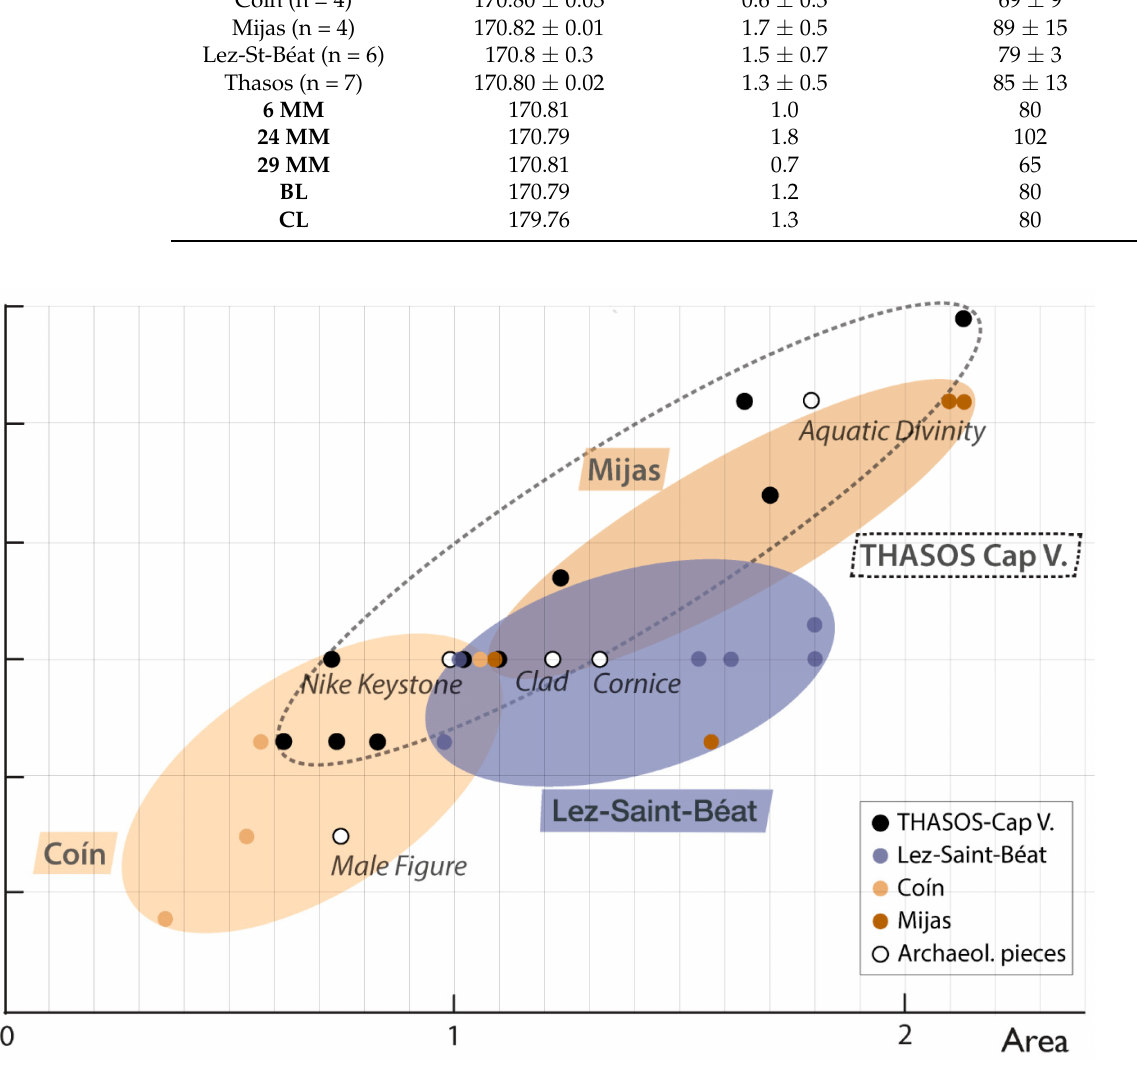
Figure 3. Area vs. full width at half-maximum ( ∆ ν 1/2 in Hz) of 13 C NMR resonances obtained for different dolomitic marbles, and first items’ provenance assignment (Male Figure 29